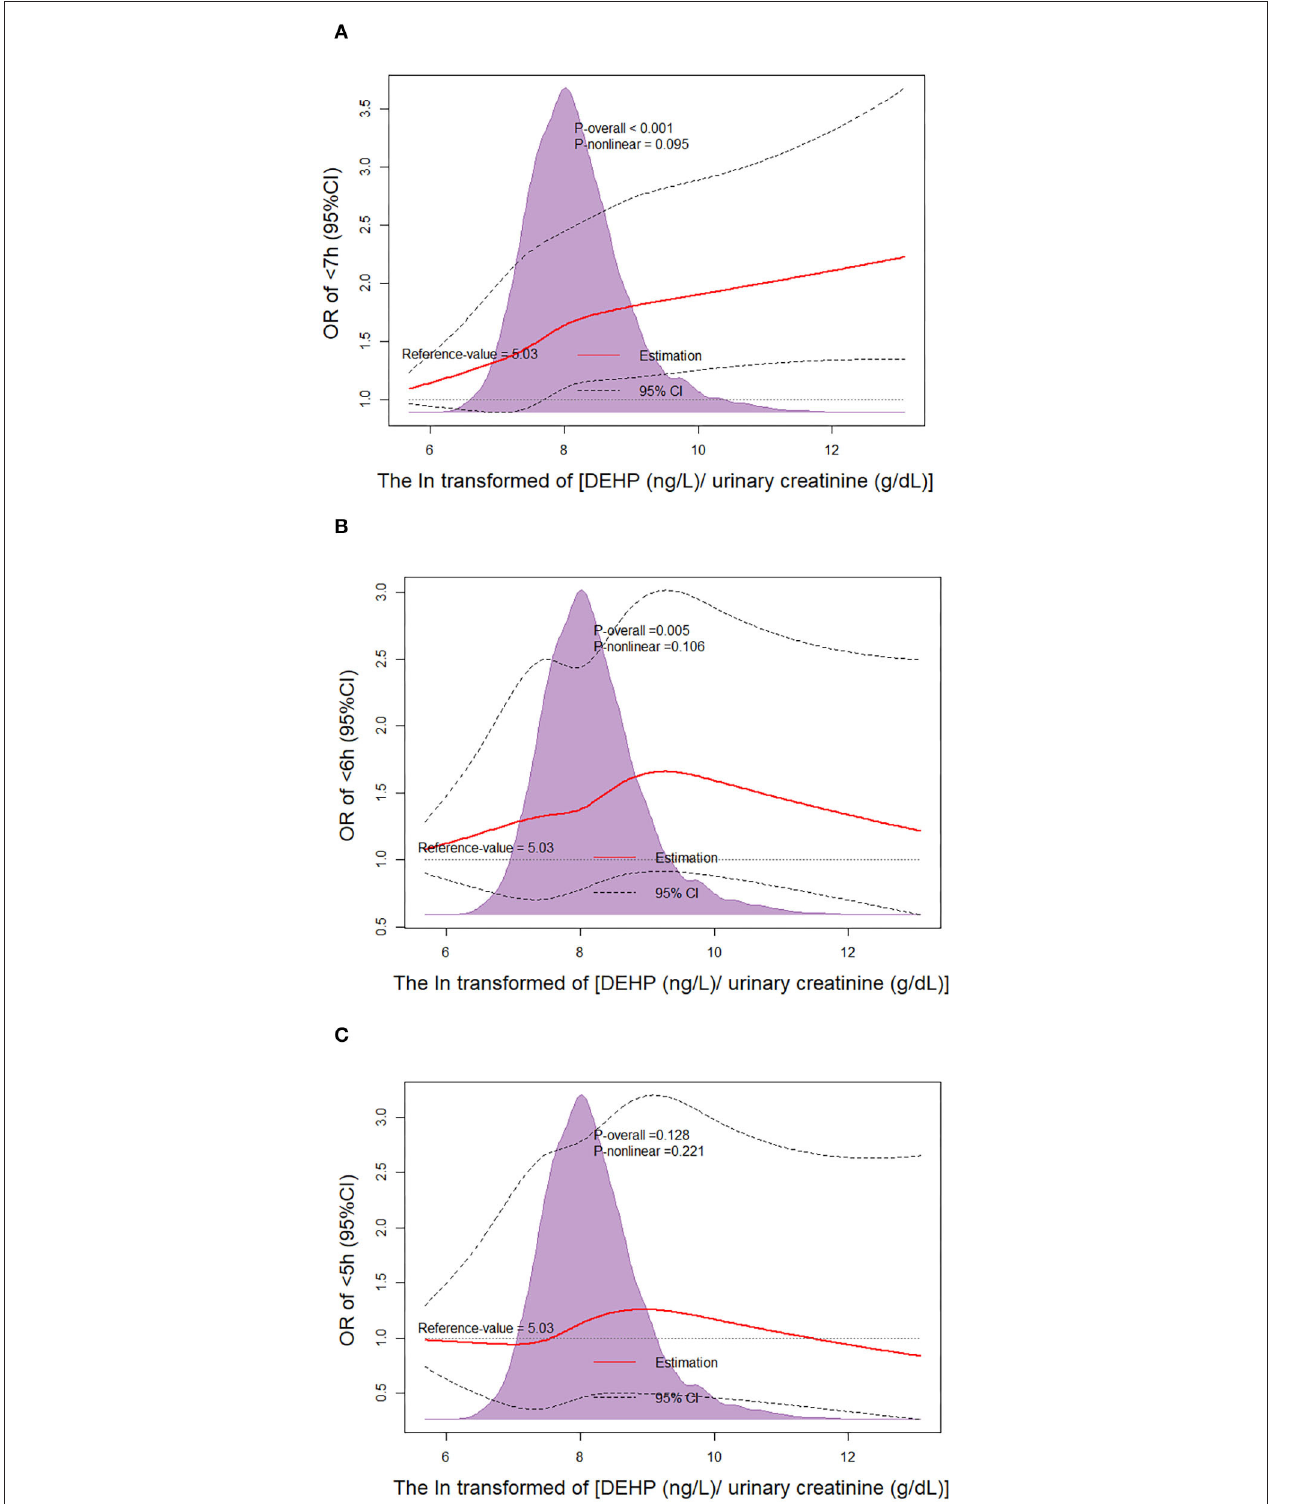
FIGURE 1 | Non-linear dose–response analysis on urinary di(2-ethylhexyl) phthalate (DEHP) concentration and short sleep duration (SSD). Restricted cubic spline regression with three knots at the 10th, 50th, and 90th percentiles was used to explore the potential dose–response relationship between DEHP and SSD. The reference level was set at 5.03. A P non − linearity was obtained by testing the null hypothesis that the regression coefficient of the second spline was equal to zero. CI, confidence interval; (A) Non-linear dose–response analysis on ln(DEHP/UCr) and SSD < 7h; (B) Non-linear dose–response analysis on ln(DEHP/UCr) and SSD < 6h; (C) Non-linear dose–response analysis on ln(DEHP/UCr) and SSD < 5 h.